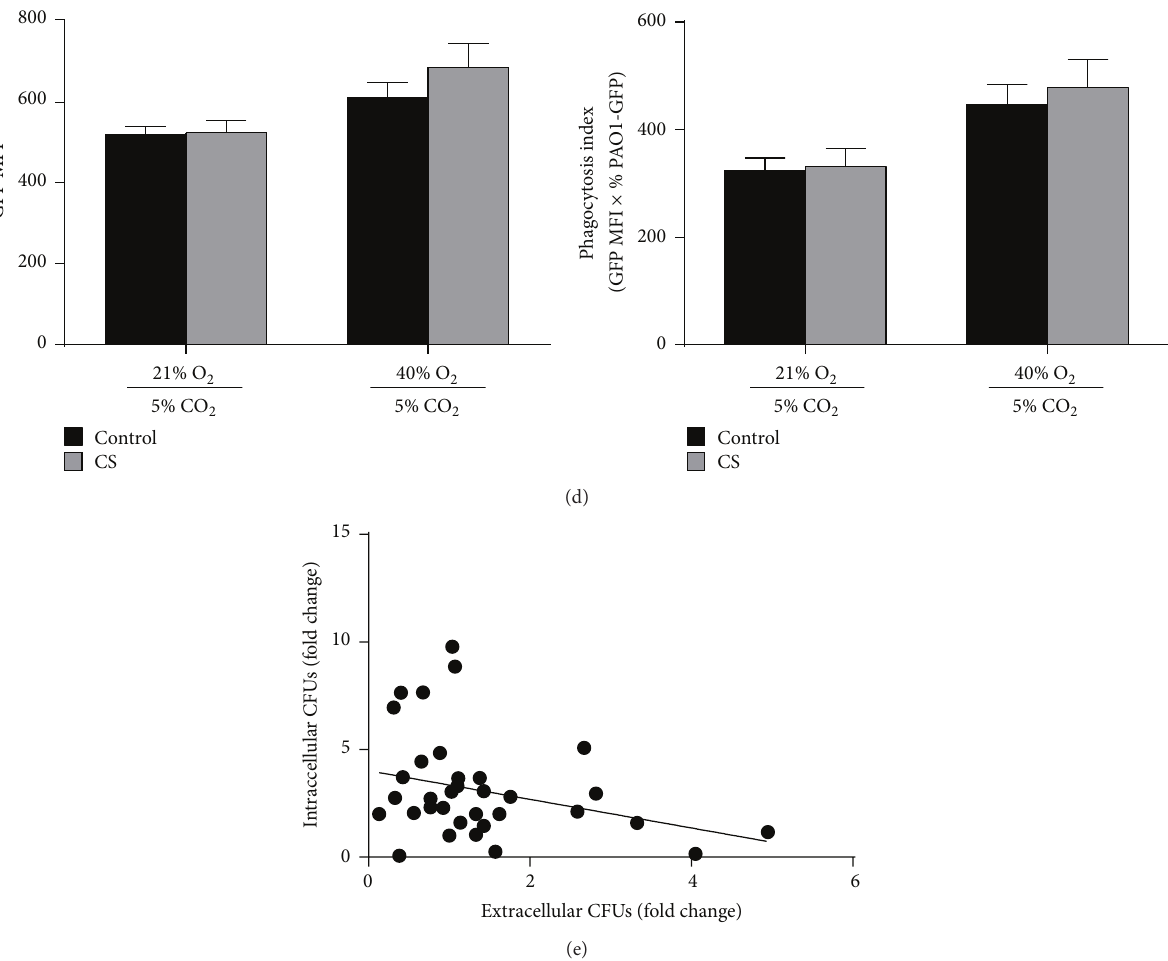
Figure3: 40%oxygen promotesbacterial clearance by CS-exposedmacrophages. MH-Smacrophages incell culturewereexposed tocigarette smoke (CS) or air (control) and 21% or 40% oxygen exposure for a total of 24 hours. (a) We quantified cytokines IL-6 and TNF- 𝛼 in the cell- free media following the specified CS and oxygen exposure ( 𝑛 = 3 , mean ± SEM, ∗ 𝑝 < 0.05 by one-way ANOVA). (b) Using FACS, we measured CD86 and MMR MFI on CD11b + cells prior to PAO1-GFP exposure (MFI ± SEM, 𝑛 = 3 , ∗ 𝑝 < 0.05 compared to the control + 21% O 2 group by one-way ANOVA with Bonferroni correction). (c) Following 24 hours of CS and oxygen exposure (or controls), we incubated cells with PAO1-GFP for 3 hours. Intracellular CFUs were expressed as a fold change compared to the control + 21% O 2 group (mean ± SEM, 𝑛 = 9 , ∗ 𝑝 < 0.05 compared to control + 21% O 2 and CS + 21% O 2 groups by one-way ANOVA with Bonferroni correction). (d) Using FACS following PAO1-GFP exposure, we quantified the MFI of GFP expression among MH-S cells (left) as well as the phagocytosis index (GFP MFI × % MH-S cells with GFP signal). (e) Following PAO1-GFP exposure, we performed nonlinear regression of best fit across all data points to demonstrate the relationship of intracellular and extracellular CFU counts (each dot represents a single well, 𝑛 = 8 -9 for each